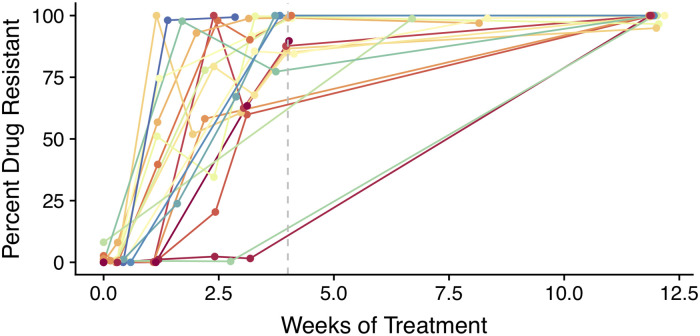
Frequencies of drug resistance mutation M184V in response to 3TC monotherapy in 20 patients.In total, 16/20 have drug resistance observed above frequency 50% in 4 weeks (approximately 28 generations, shown in dashed line). Moreover, 19/20 have drug resistance above 50% in 12 weeks. The patient with no drug resistance is not plotted. Data replotted from Schuurman et al. [13] via WebPlotDigitizer [18].